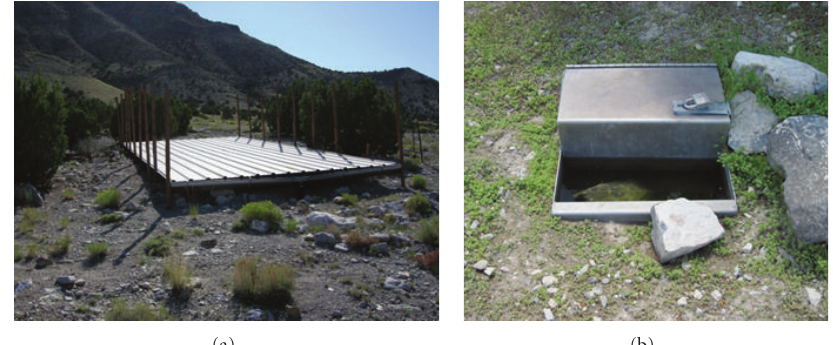
Figure 1: Typical wildlife water development on the Thomas-Dugway Mountains in western Utah, USA, including catchment apron (a) and drinker (b) where we photographed mule deer using water sources,